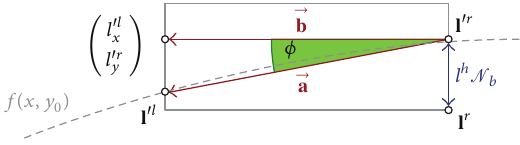
Figure 12: Arranging a letter along the